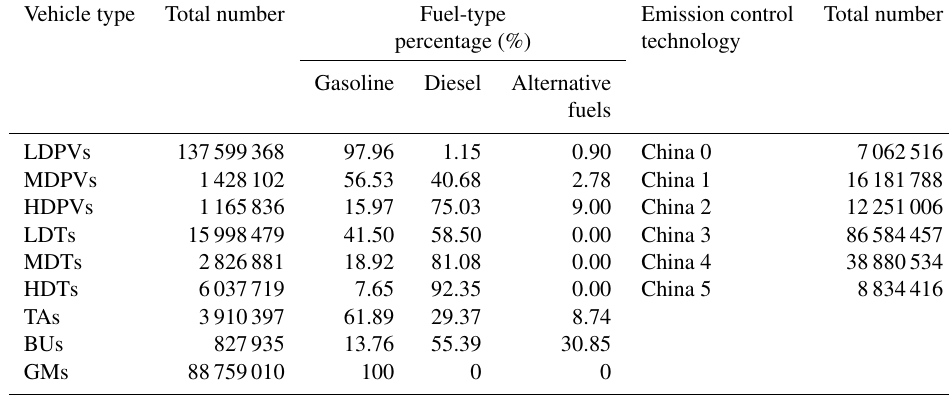
Table 1. Total number of vehicles of different types in China in 2015.